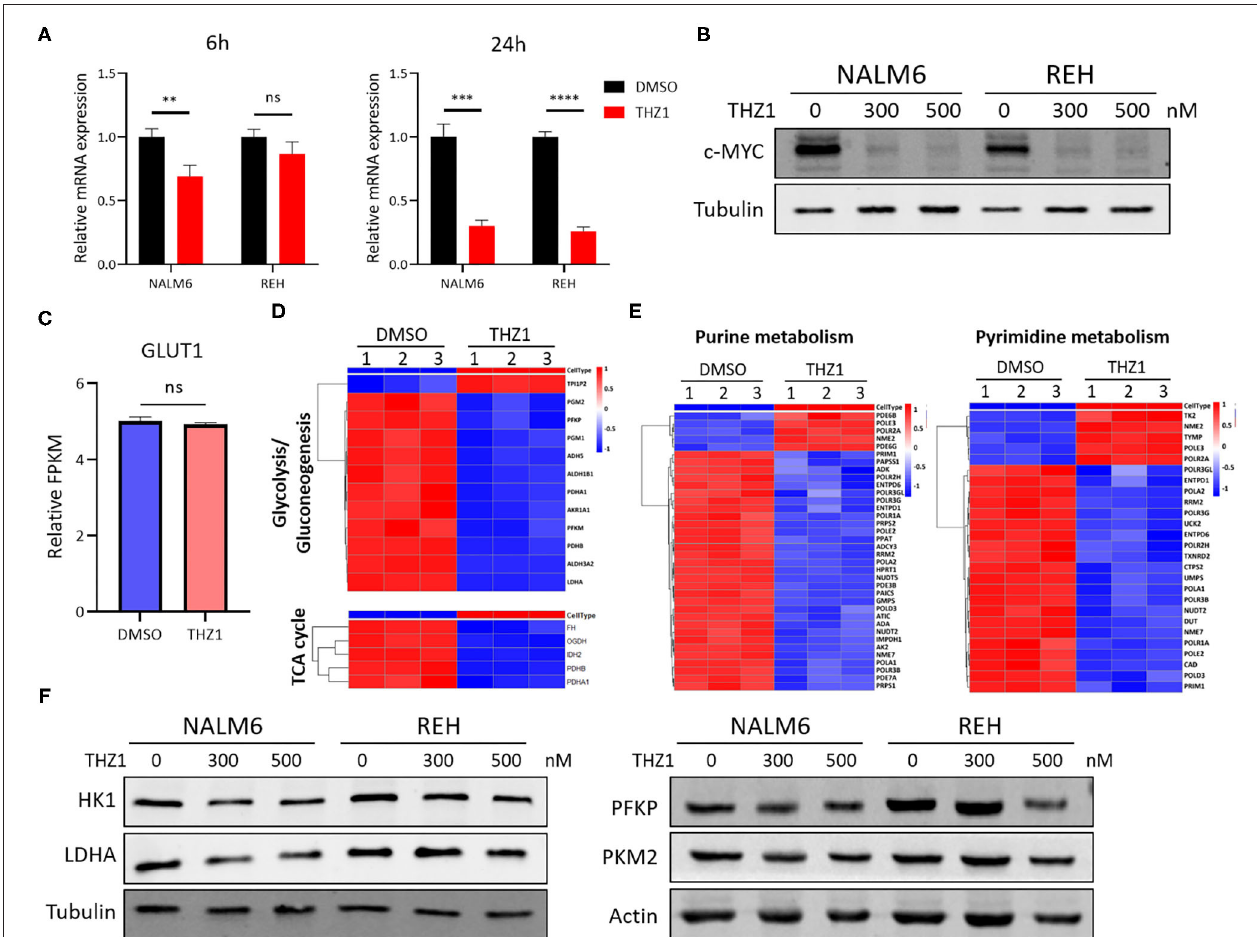
FIGURE 6 | THZ1 disturbs the cellular metabolism of B-ALL cells by downregulating c-MYC-mediated metabolic enzymes. (A) Relative mRNA expression of c-MYC was measured by qRT-PCR in THZ1- and DMSO-treated NALM6 and REH cells. (B) Protein expression of c-MYC was determined by Western blot in THZ1- and DMSO-treated NALM6 and REH cells. (C) Relative mRNA expression of GLUT1 was measured by RNA-SEQ in THZ1- and DMSO-treated NALM6 cells. (D,E) Heatmap of glucose, amino acid, and nucleotide metabolism-related genes was analyzed by RNA-SEQ in THZ1- and DMSO-treated NALM6 cells. (F) Protein expression levels of glucose and nucleotide metabolism-related genes, such as HK1, LDHA, and PFKP, were detected by Western blot in THZ1- and DMSO-treated NALM6 and REH cells. B-ALL cells were treated with THZ1 for 24h. Values were shown as mean ± SEM. ** p < 0.01, *** p < 0.001, and **** p <